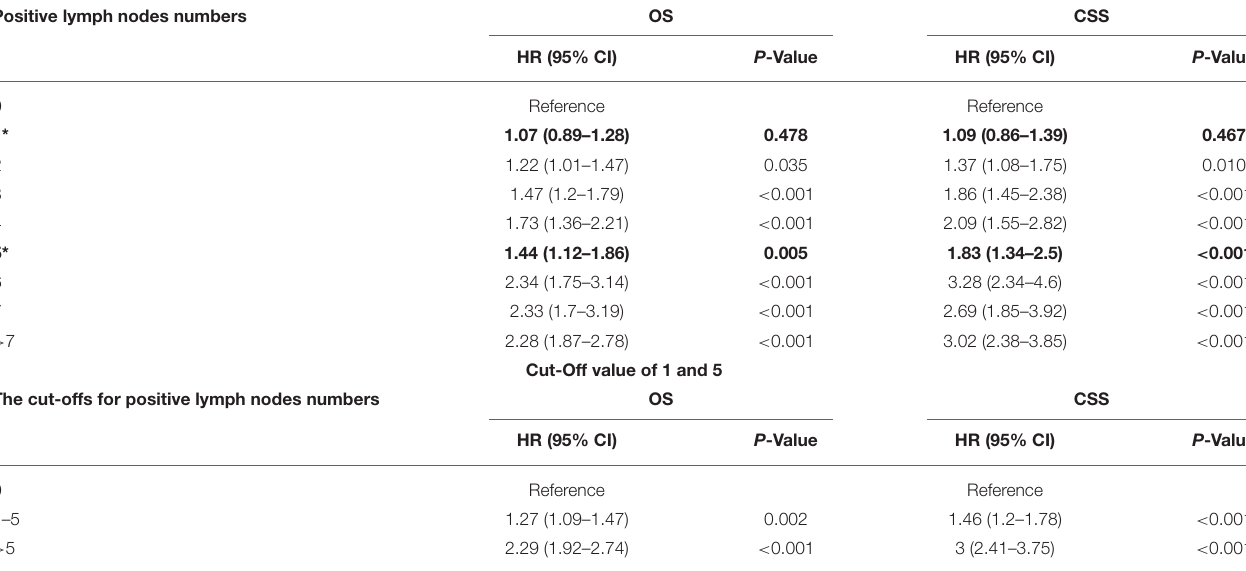
TABLE 2 | Multivariable analysis for the increasing positive lymph nodes numbers and the cut-offs. Positive lymph nodes